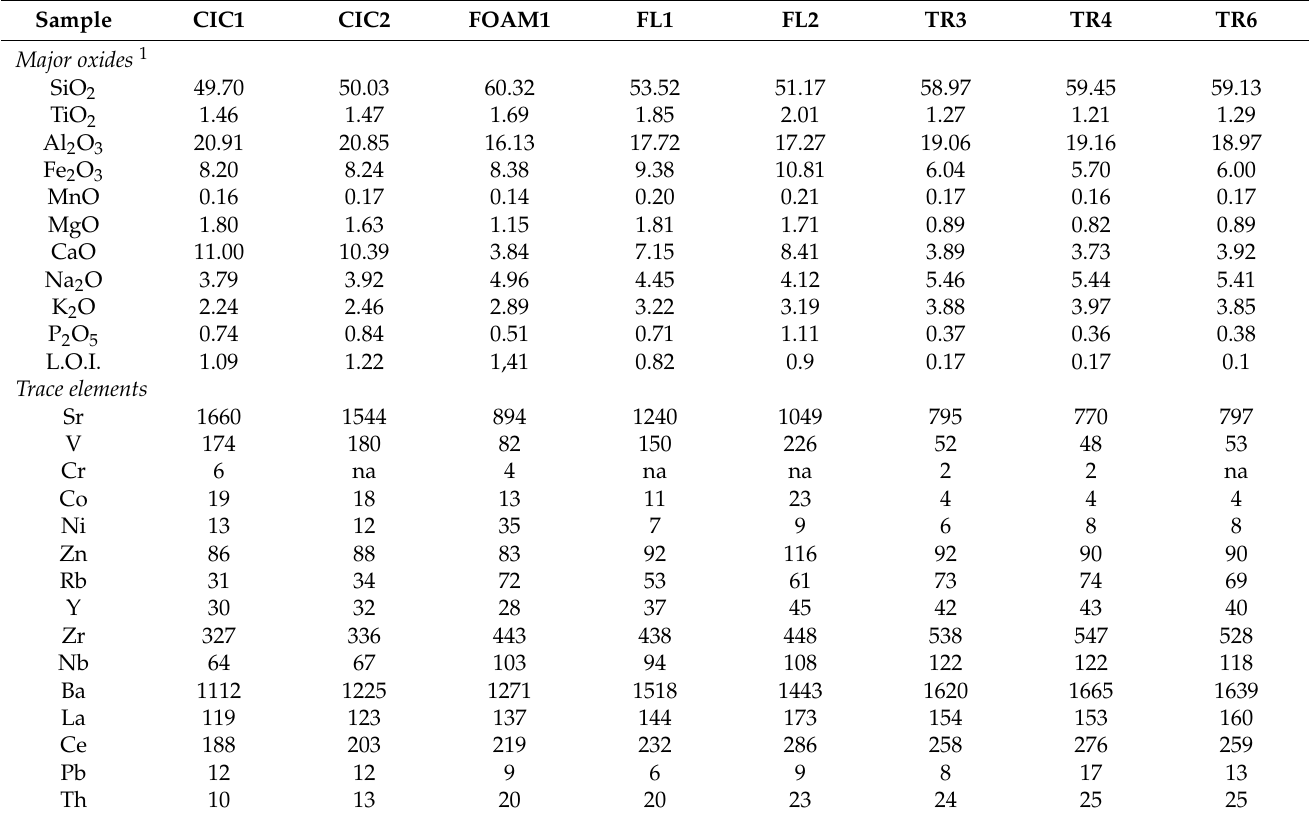
Table 2. Results of whole-rock analysis for major oxides (wt.%) and trace elements (ppm).